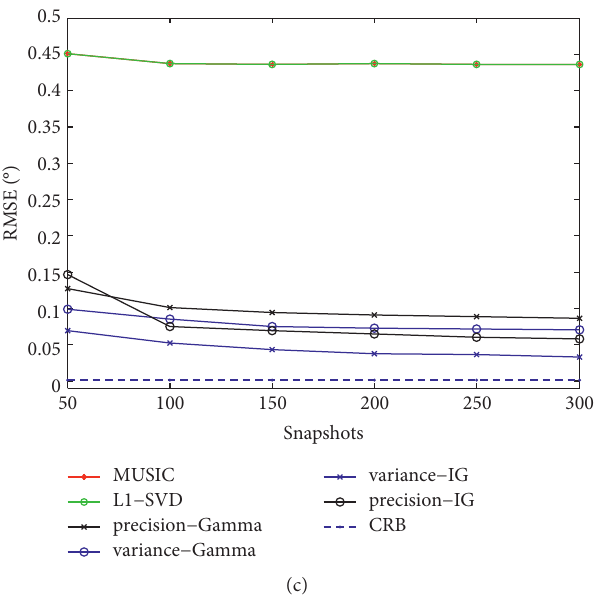
Figure 6: RMSE versus parameters: (a) RMSE with different SNR values; (b) RMSE with different array elements; and (c) RMSE with different